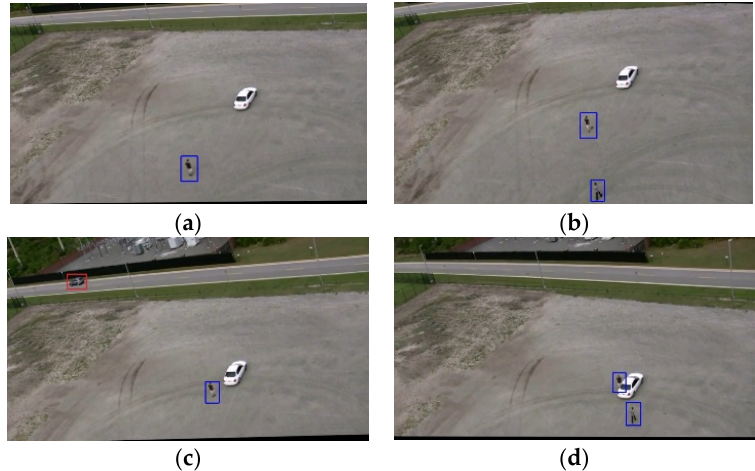
Figure 10. The result of moving object detection in Action1: ( a ) Frame 25, ( b ) frame 100, ( c ) frame 210, ( d ) frame 405.